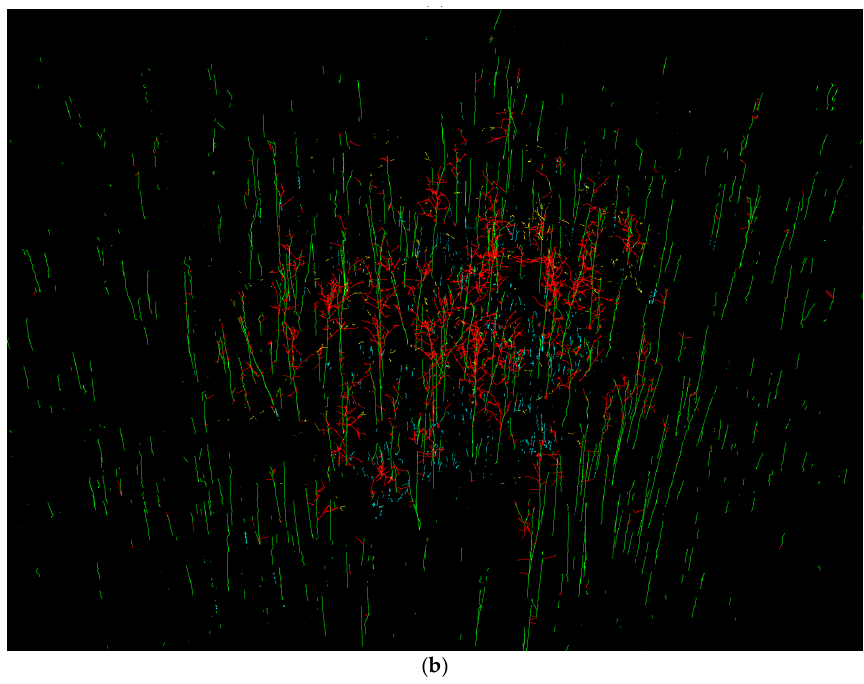
Figure 11. Example wood reconstruction from a maple plot (1 ha): ( a ) a 3-D FCN filtered plot scan, with stem in green, branch in red, and other points in blue; ( b ) QSM reconstructed wood curves, with stem in green, branch in red, understory in cyan, and isolated wood in yellow. To balance the level of graphic details, blue points in ( a ) are assigned with transparency degree of 0.99, and stem curves are set four times thicker than all other curves.